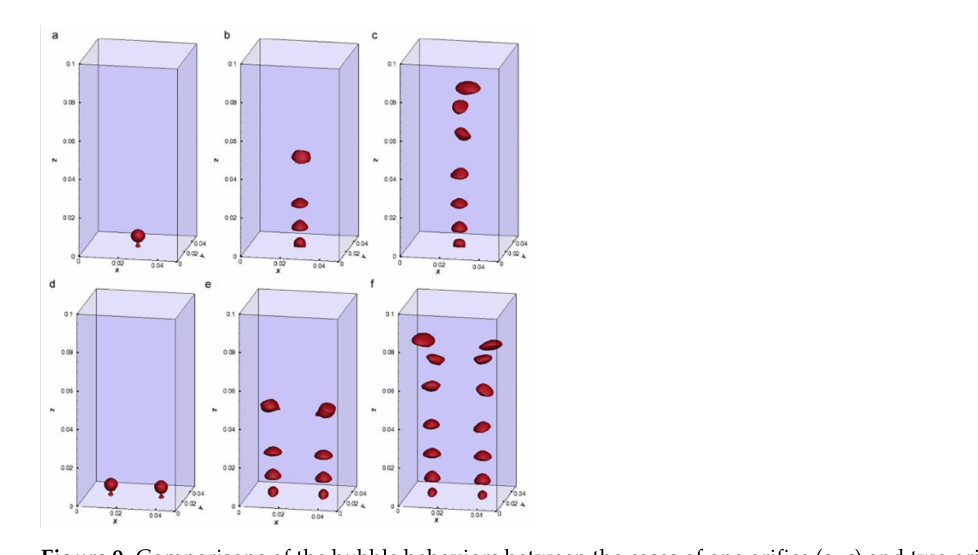
Figure 9. Comparisons of the bubble behaviors between the cases of one orifice ( a – c ) and two orifices ( d – f ) with vg of 3 m/s and a vl of 0.01 m/s. ( a ) t = 0.050 s, ( b ) t = 0.225 s, ( c ) t = 0.375 s, ( d ) t = 0.050 s, ( e ) t = 0.225 s, and ( f ) t = 0.375 s.